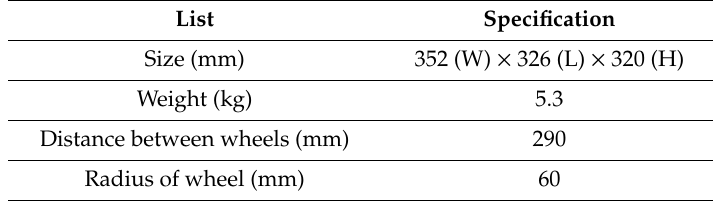
Figure 8. Moving object (master robot). Table 5. Hardware specifications of the moving object.